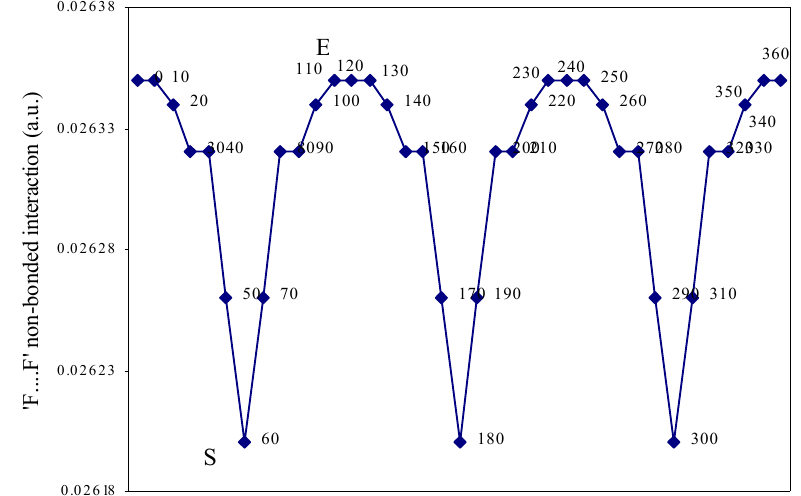
Figure 10. Plot of two-center 'F···F' non-bonded interaction energy of F as a function of torsional angles (E-Eclipsed, S-Staggered)